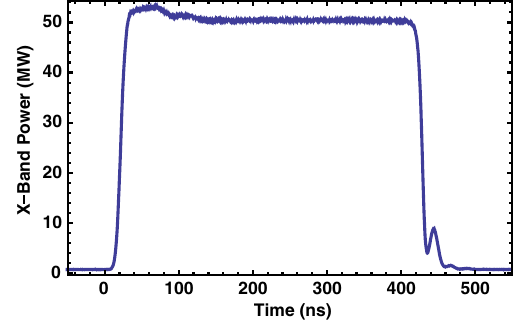
FIG. 2. Measured 400 ns XL-4 klystron rf output power pulse. Small reflections observed at start and end of pulse from reflections in the directional coupler and load